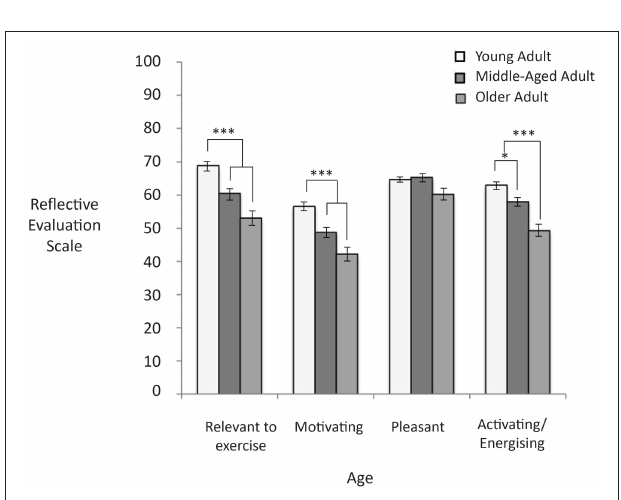
FIGURE 5 | Higher scores represent higher reflective evaluation ratings on the 0–100 response scale. Significant differences are noted with asterisks. Error bars reflect standard errors.